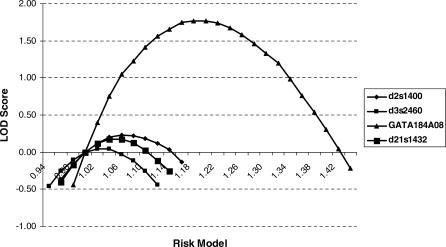
An Analysis of LOD Scores at Varying Risk Models Reveals Weak Evidence for Association of Previously Published Loci with HTNUsing the distribution of LOD score shown below, we estimated a HTN odds ratio of 1.19 (95% credible interval 1.06–1.34) for inheritance of the African allele at the 6p24.1 (GATA184A08) locus, and odds ratios of 1.06 (0.94–1.21), 1.04 (0.95–1.17), and 1.02 (0.92–1.15) for the 2p25.1 (d2s1400), 21q21.1 (d21s1432), and 3q13.31 (d3s2460) loci, respectively.